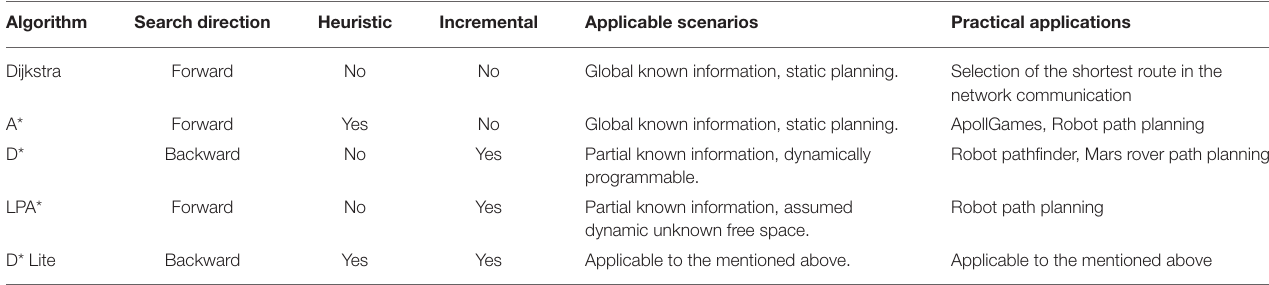
TABLE 1 | Performance comparison of the search algorithms:Dijkstra (Wang et al., 2011), A* (Le et al., 2018), D* (Xue et al., 2014), LPA* (Koenig et al., 2004), and D* Lite (Koenig and Likhachev, 2005).